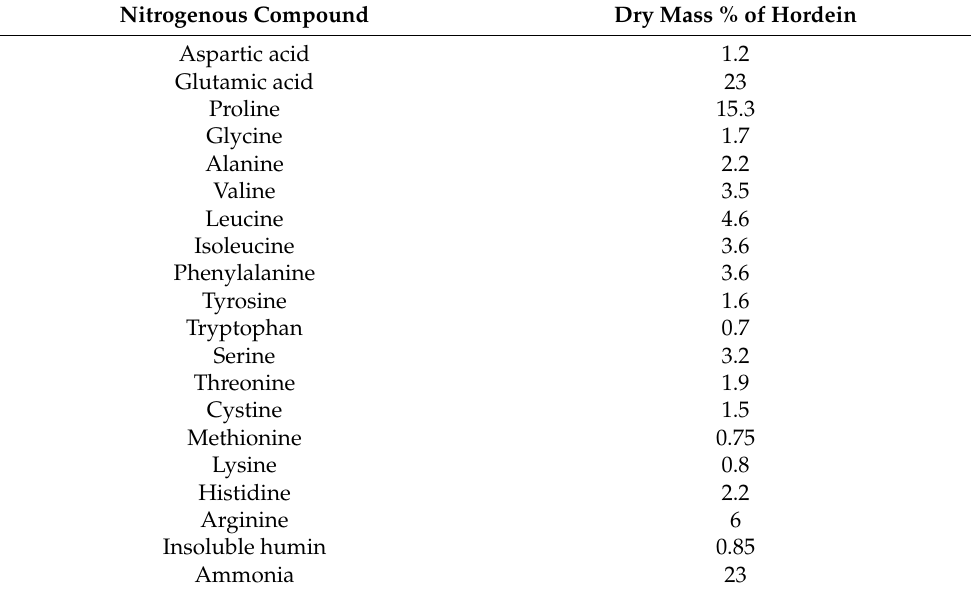
Table 1. Amino acid composition of barley proteins, adapted from [12].